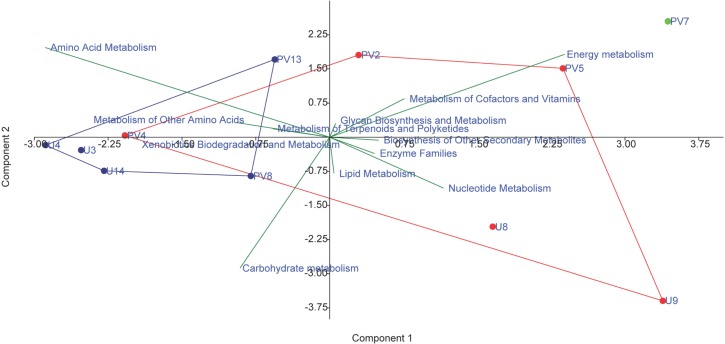
PCA biplot on the basis of the most abundant metabolism related to archaeal genes in the predicted metagenomes; red symbol depicts basaltic samples; blue symbol depicts granitic samples and green symbol depicts transition zone sample.